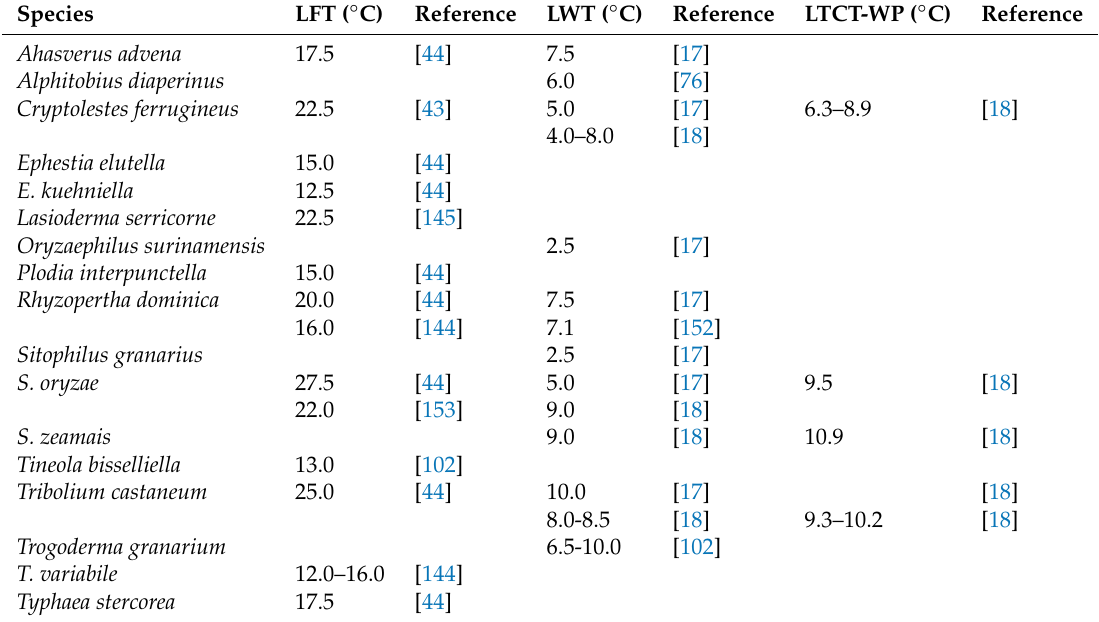
Table 8. Summary of threshold temperatures for flight (LFT), walking (LWT) and trap capture (LTCT-WP) for stored product insects (Coleoptera,